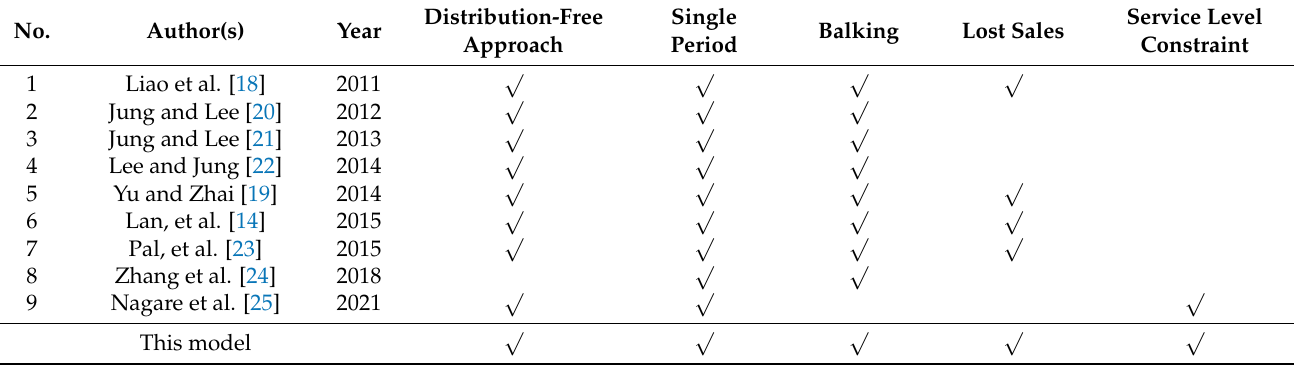
Table 1. Literature related to this